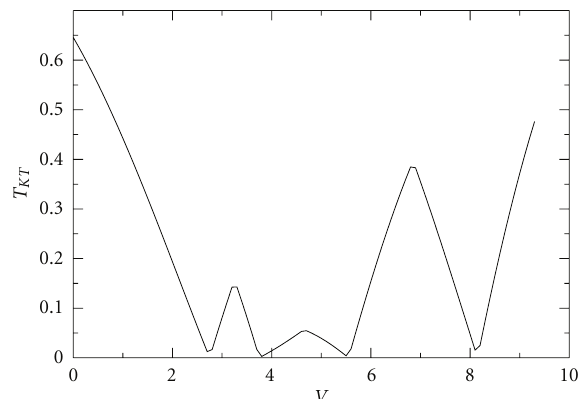
Figure 7: T KT in units of J/k B as a function of V for a 16 × 16 unit cell at U = 8. Dramatic decreases in the transition temperature T KT separating the low-temperature ferromagnetic phase from high-temperature paramagnetic phase occur due to changes in the topological density of the ground-state at critical potential